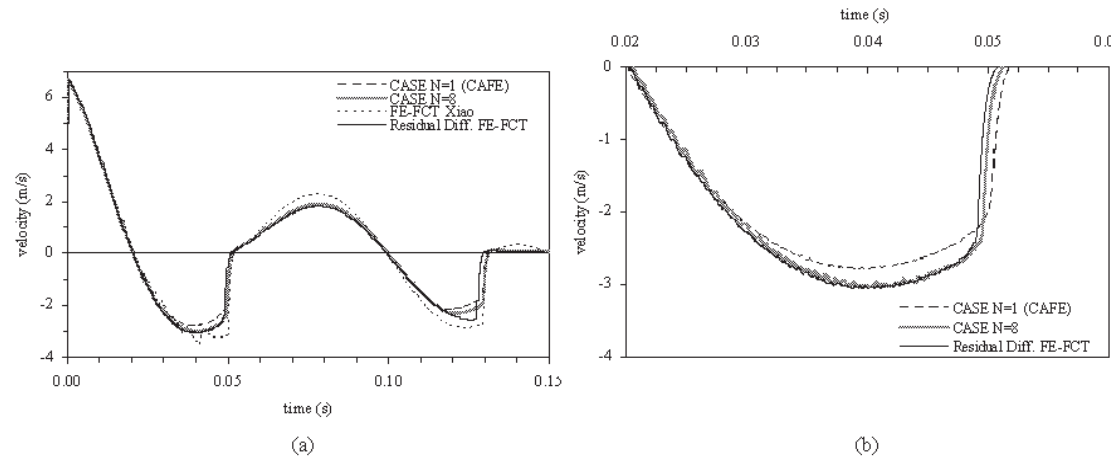
Fig. 6. Results for the velocity of m 1 on two time scales using 161 fluid